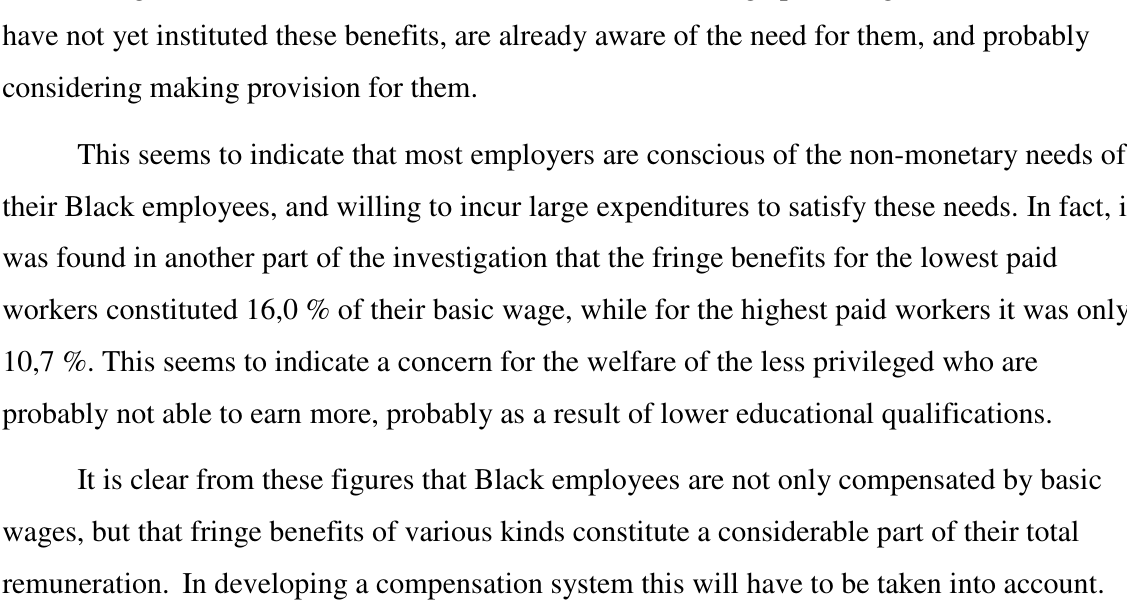
FRINGE BENEFITS FOR BLACK WORKERS GRANTED AND CONSIDERED A NEED (N = 109) GRANTED % A NEED % Medical aid 43,1 40,4 Pension scheme 76,2 21 ,1 Paid sick leave 89,9 6,4 Holiday bonuses 67,0 17,4 Production or merit bonuses 34,9 28,4 Long service bonuses 53,2 20,2 Housing benefits 29,4 38,5 Transport allowance 35,8 22,0 Feeding schemes 53,2 25,7 Work clothes or allowance 86,2 9,2 Educational scheme 37,6 Purchasing facilities 35,8 16,5 Recreational facilities 35,8 34,9 Saving schemes